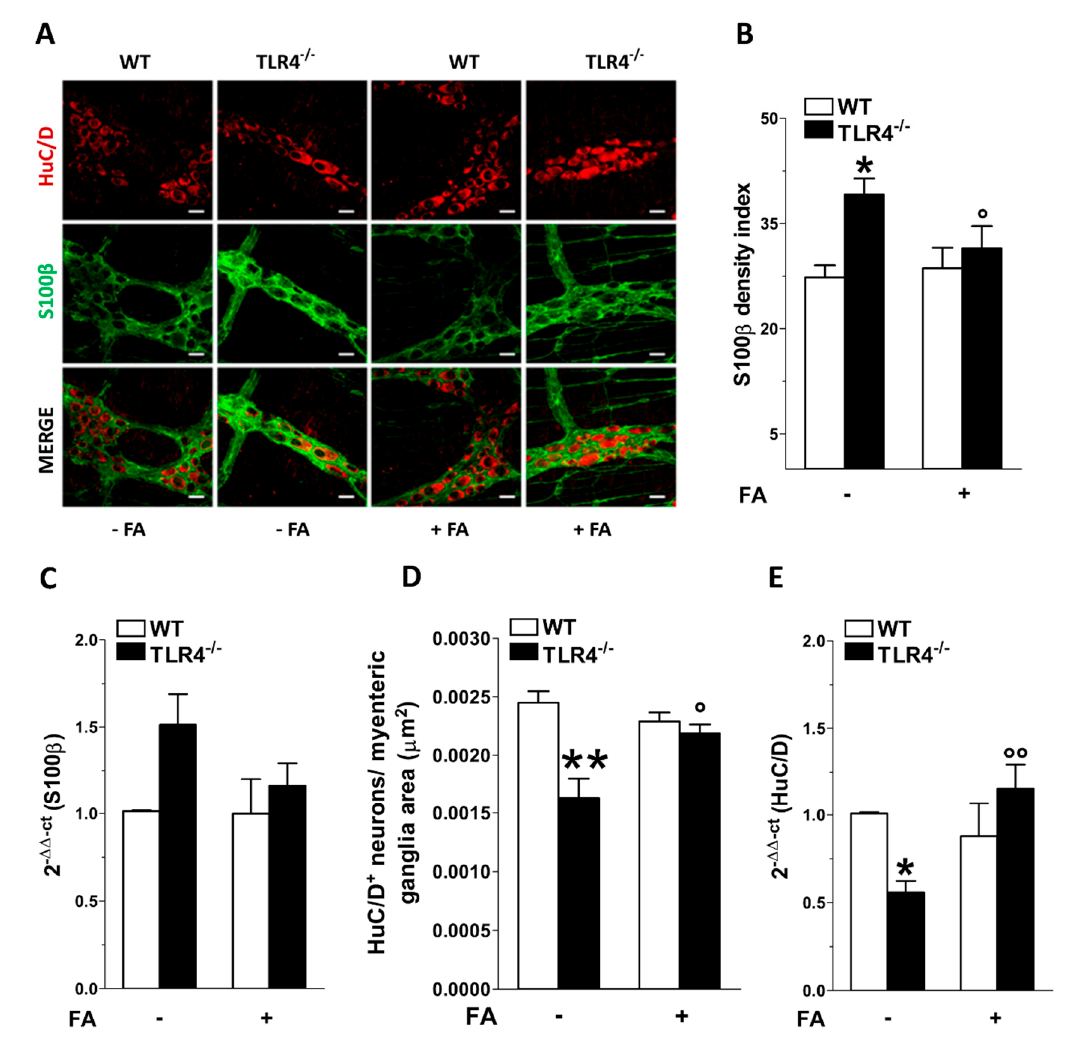
Figure 1. Effect of fluoroacetate (FA) treatment on myenteric ganglia neural and glial cells. ( A ) Representative confocal microphotographs showing the distribution of S100 β (green) and HuC/D (red) in small intestine LMMPs of WT and TLR4 − / − mice in the presence or absence of 10 µM FA (bars = 22 µm). ( B , C ) Analysis of S100 β density index in ileal myenteric ganglia ( B ) and S100 β mRNA levels in small intestine segments ( C ) of WT and TLR4 − / − mice in the presence or absence of 10 µM FA. ( D , E ) Total number of HuC/D + neurons in ileal myenteric ganglia ( D ) and HuC/D mRNA levels in small intestine segments ( E ) of WT and TLR4 − / − mice in the presence or absence of 10 µM FA. Data are reported as mean ± SEM for all panels. * P < 0.05, ** P < 0.01 vs WT; ° P < 0.05, °° P < 0.01 vs respective control without FA; N = 6 mice/group.